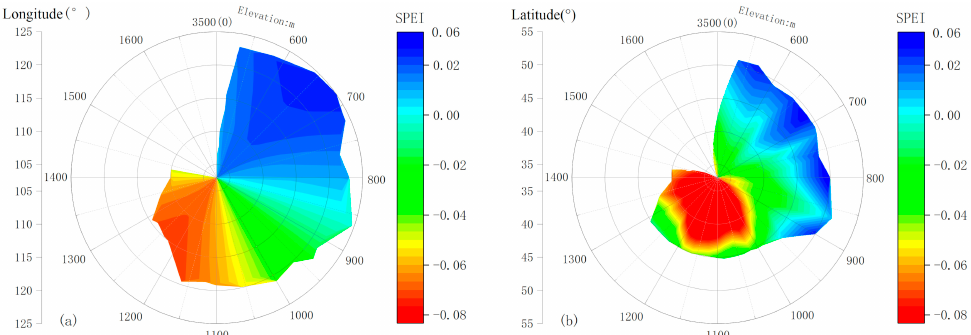
Figure 3. Spatial distribution of multi-year mean values of SPEI during the growing season in the study area from 2000 to 2018. ( a ) Longitude and elevation statistics. ( b ) Latitude and elevation sta- tistics.